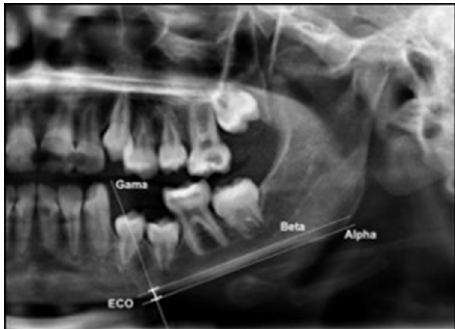
Figure 1 - Mandibular cortical width as proposed by Taguchi et al. (2004) (10). Alpha: external lamina of the mandibular basal line; Beta: internal lamina of the mandibular basal line; Gamma: perpendicular intersection at the mental foramen level. ECO: bone width of the inferior mandibular